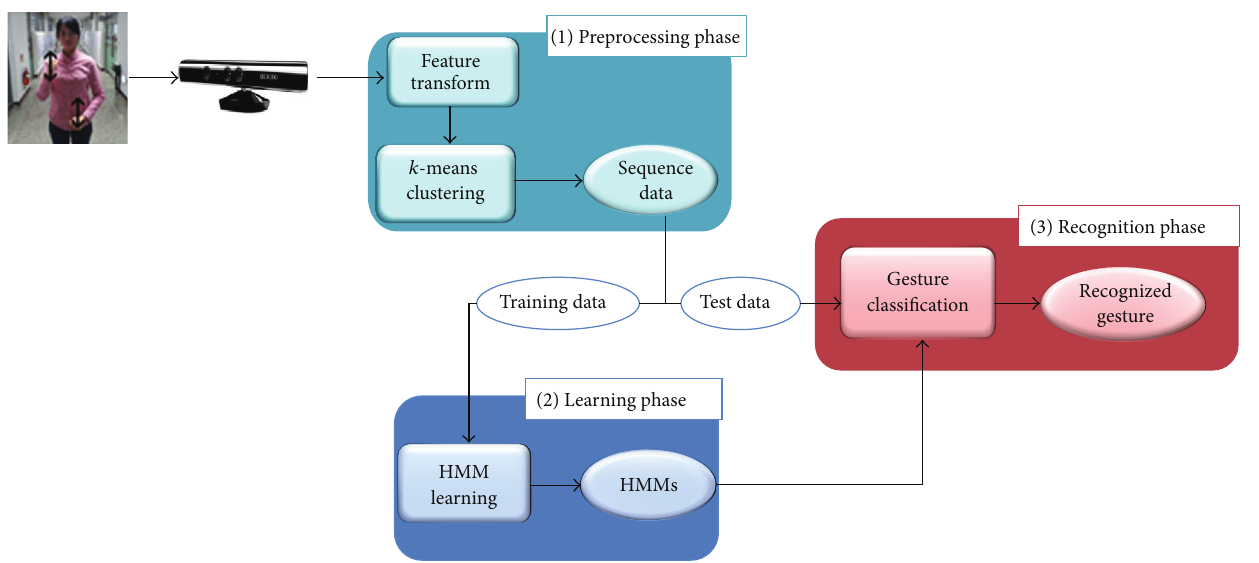
Figure 1: Overall process of arm gesture